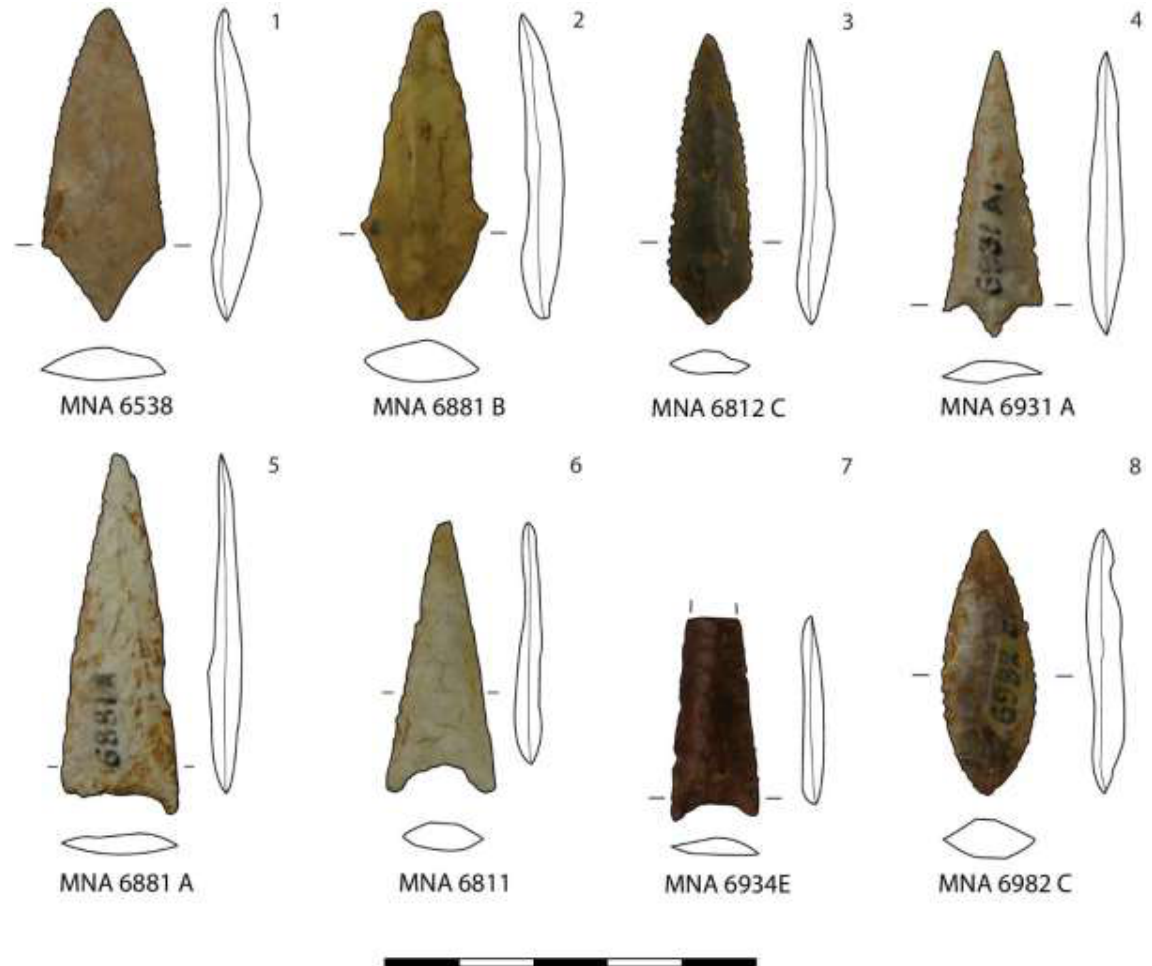
Figure 6. Different morphologies of arrowheads. 1-4: convex or triangular base; 5-7: concave base; 8: foliate. The scale bar is 5 cm long (in 1 cm